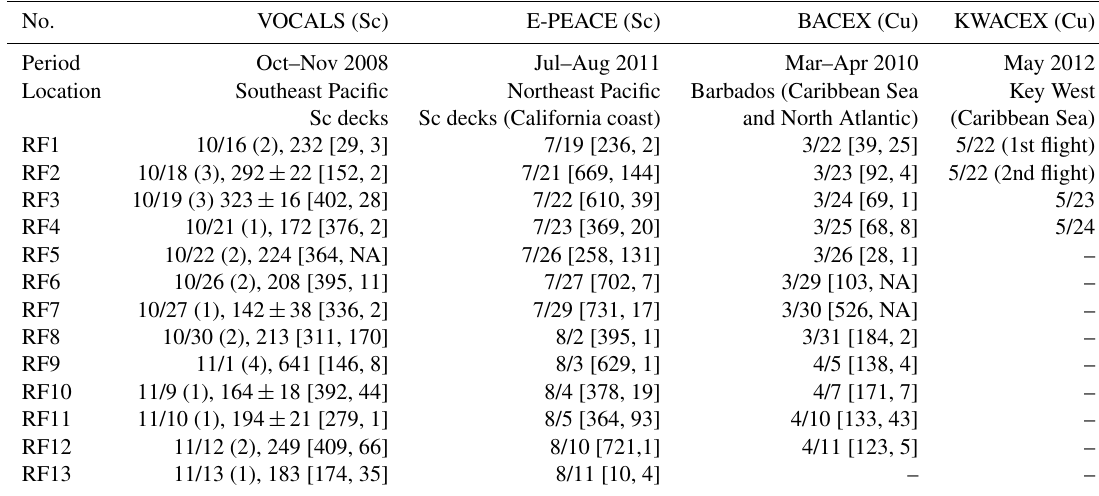
Table 1. Dates (in mm/dd format) used for this analysis during each experiment. No.